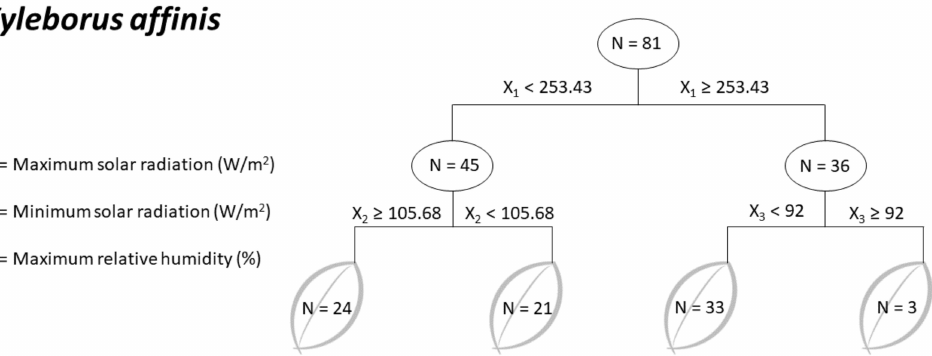
Figure 7. Decision tree schematic for Xyleborus affinis abundance using weather conditions as ex- planatory variables.